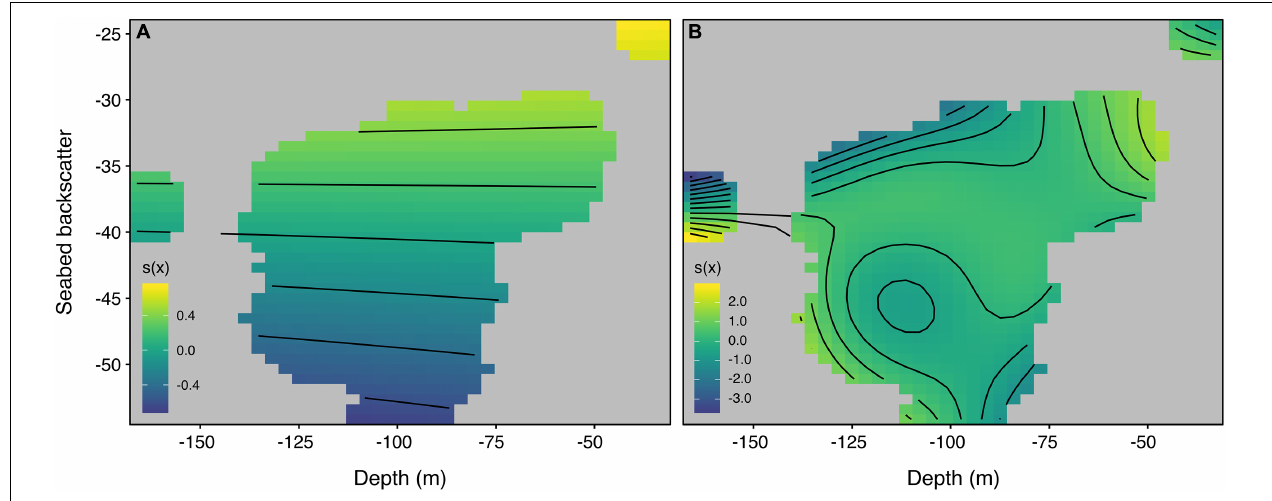
FIGURE 4 | Tensor product smooths for the non-linear interaction between seabed depth (in meters) and acoustic backscatter (in decibels) in the models of (A) species richness, S , and (B) species relative abundance, N , minimizing the second-order Akaike’s Information Criterion (AICc). Models explained 12.3 and 52.1% of the deviance,